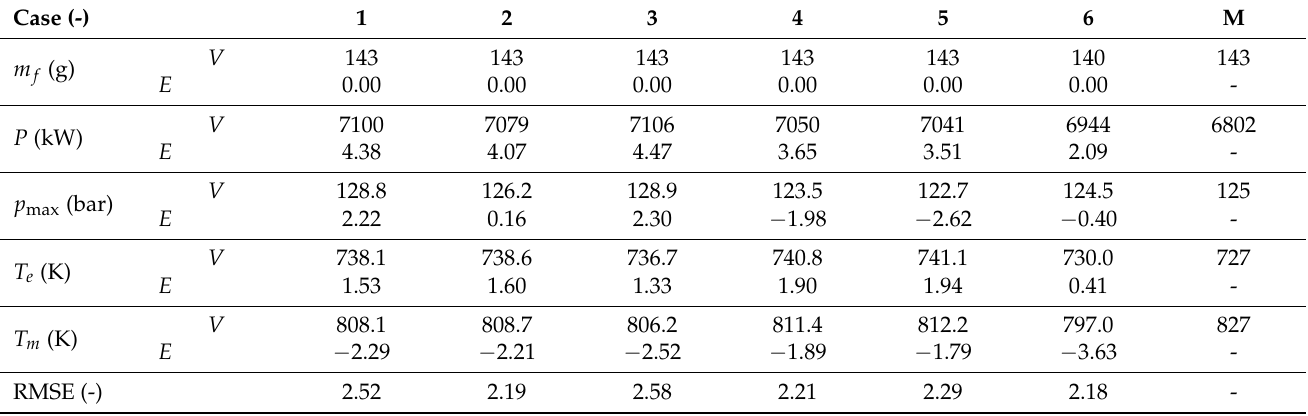
Table 13. The performance of the dual-fuel engine running in liquid fuel mode with the WA